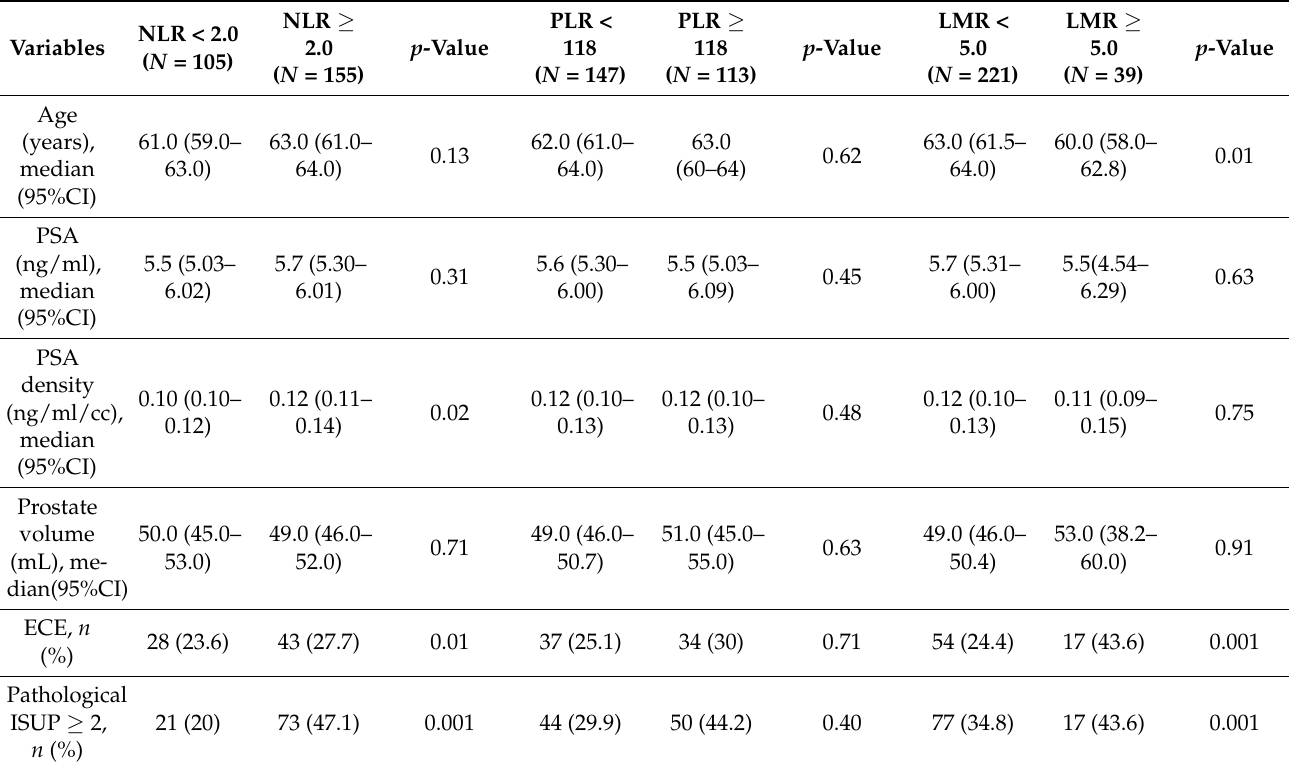
Table 2. Association of baseline clinicopathologic characteristics and NLR, PLR and LMR cut-off.